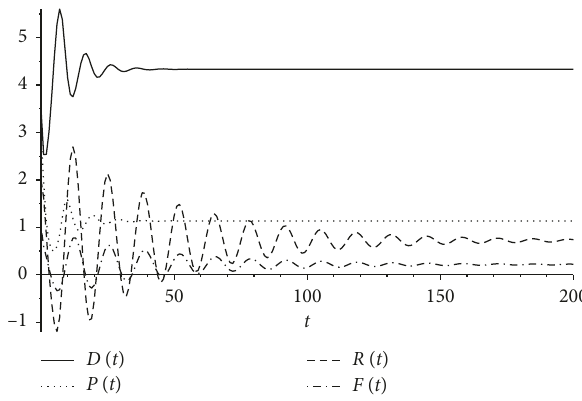
Figure 5: Numerical simulation diagram of system (2) when � 0 , τ � 5. τ 1 2